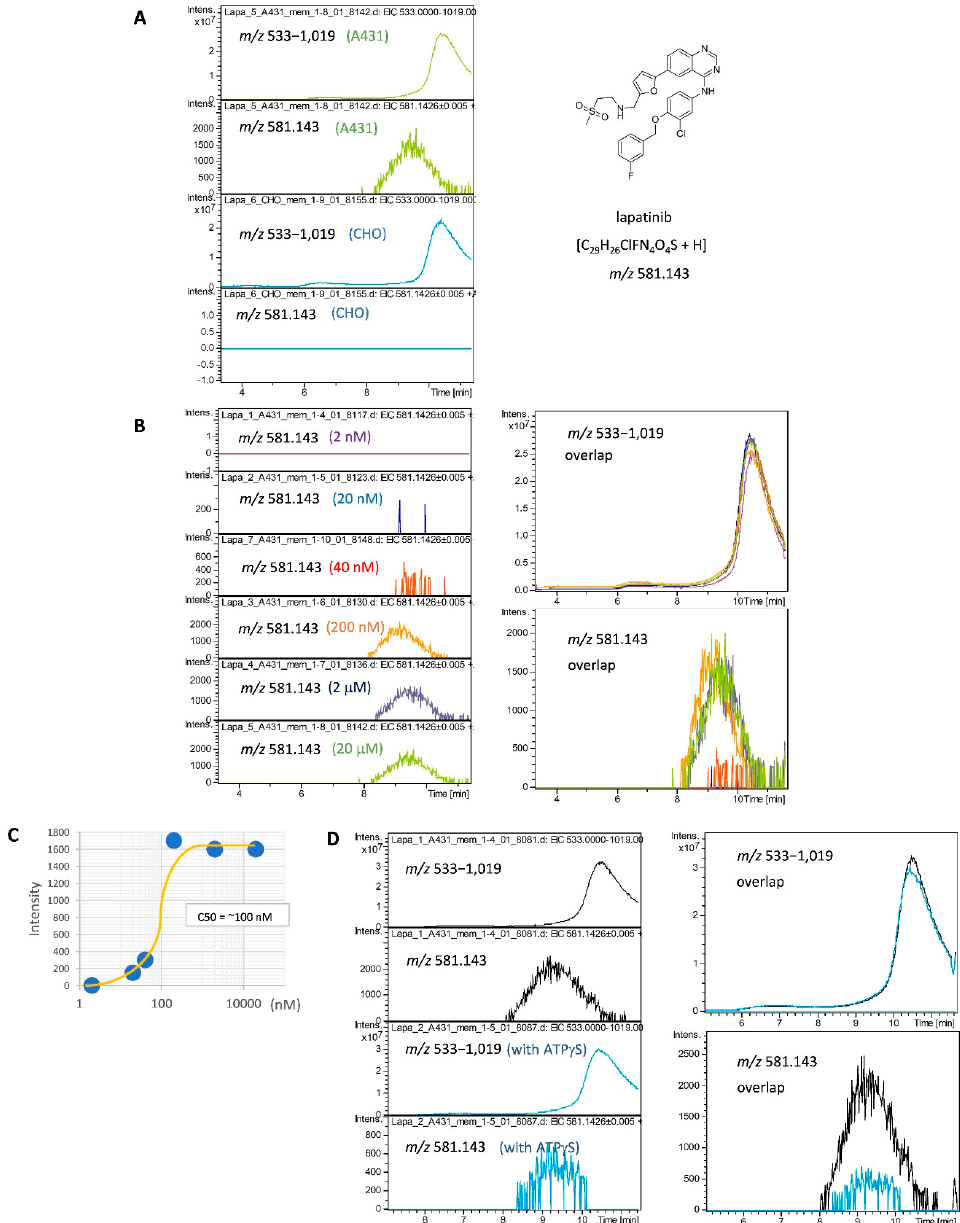
Figure 1. Detection of interaction between the A431 cell membrane protein fraction and EGFR inhibitor, lapatinib. ( A ) Comparison of A431 cells with highly expressed EGFR and CHO cells without